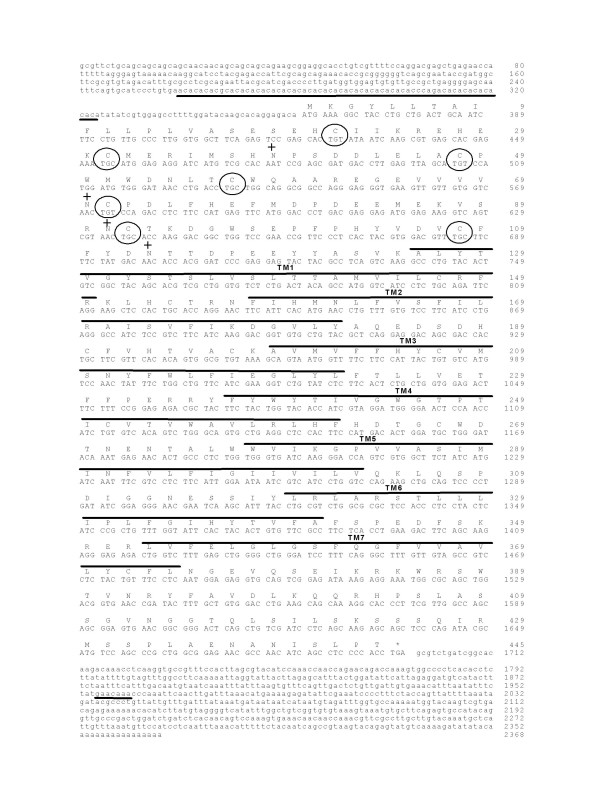
Nucleotide and predicted protein sequence of sbPAC1A receptor. Seven TM domains are highlighted with black lines and the conserved N-terminal cysteine residues and putative N-glycosylation sites are annotated respectively by a circle and by "+". The microsatellite identified in the 5'UTR is underlined and the stop codon is indicated by "*".